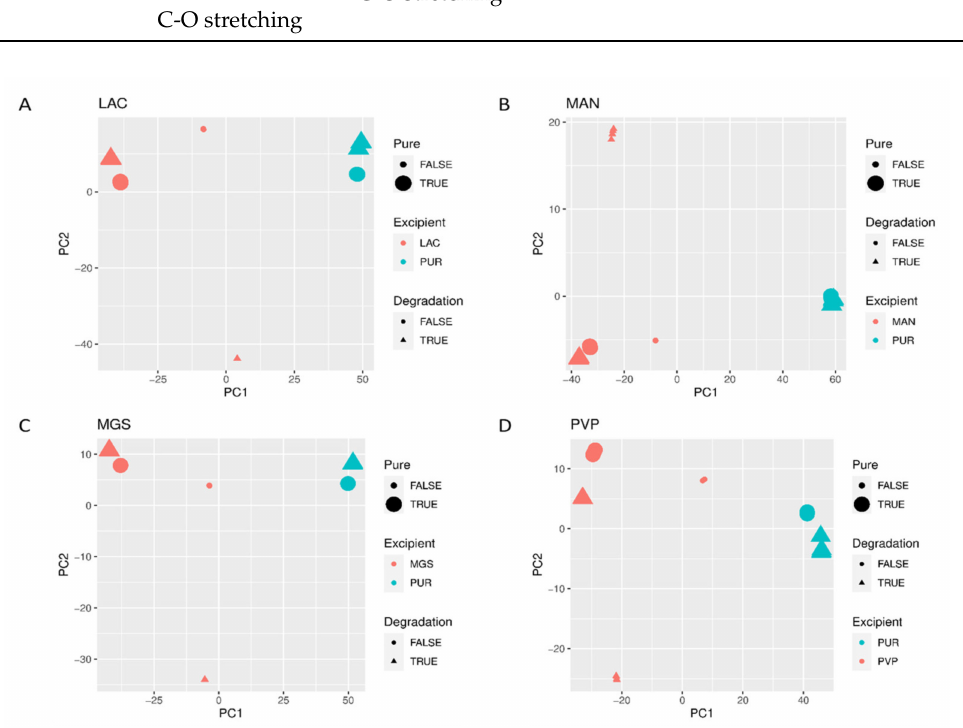
Figure 10. ( A – D ) PCA scores plots of mid-IR spectra of vildagliptin (Pure Drug) and the mixtures of vildagliptin with Excipients: ( A ) lactose (LAC), ( B ) mannitol (MAN), ( C ) magnesium stearate (MGS) and ( D ) polyvinylpirrolidone